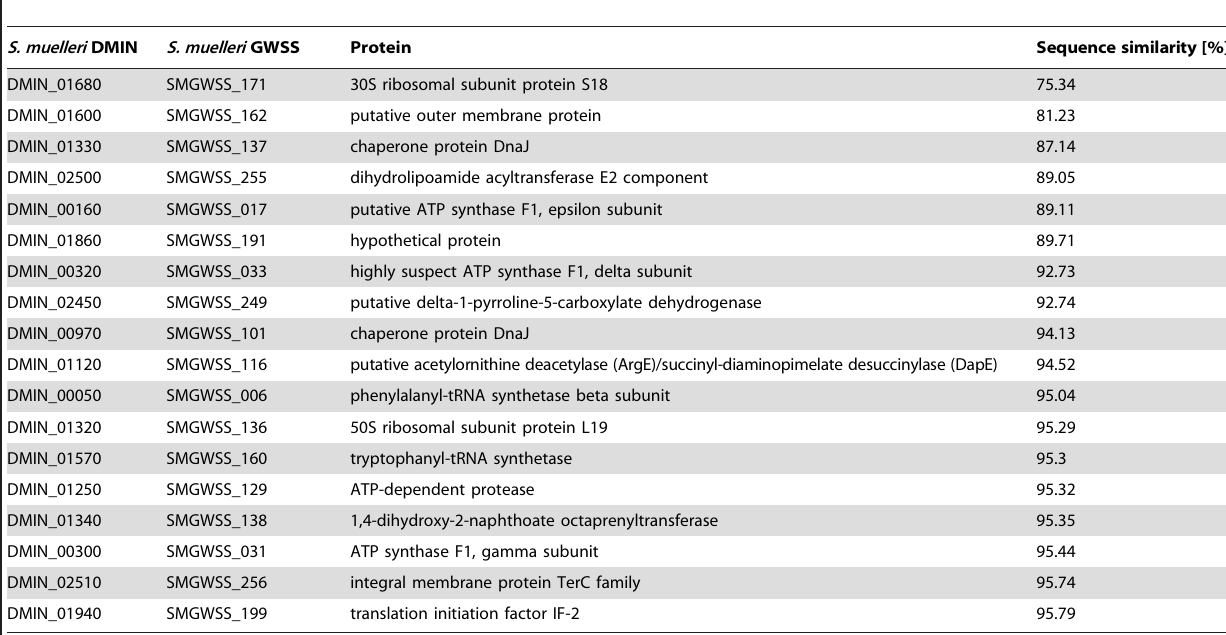
Table 2. Pairs of proteins that have low sequence similarity between Candidatus S. muelleri DMIN and Candidatus S. muelleri GWSS.